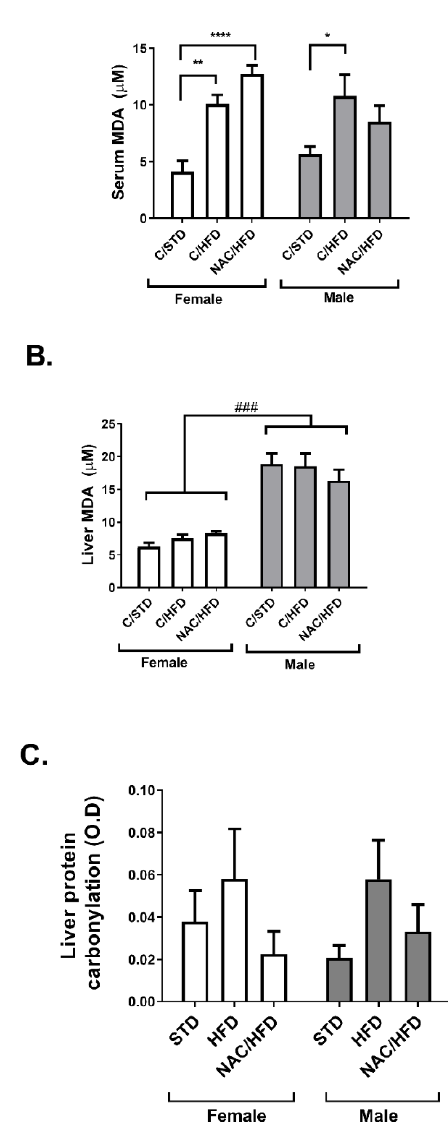
Figure 5. Effect of early life administration of NAC on markers of oxidative stress in HFD-fed mice. NAC was given to females during pregnancy and lactation. HFD was given to offspring from the age of 6 weeks. Mice were killed at age 16 weeks and serum ( A ) and liver ( B ) thiobarbituric acid reactive substrate (TBARS) were measured. ( C ) Protein carbonylation was measured in liver, as describes in Methods. The results are presented as mean ± SE ( n = 8), * p < 0.05, ** p < 0.005, **** p < 0.0.0005 in one-way Anova followed by Tukey’s post-test. ### p < 0.0005 in two way Anova followed by Bonferroni’s post-test.